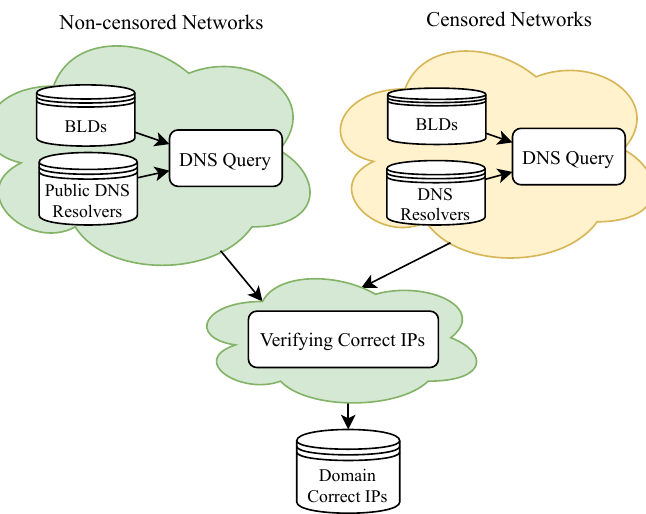
Figure 5. Processing chain to obtain and verify domain correct IP